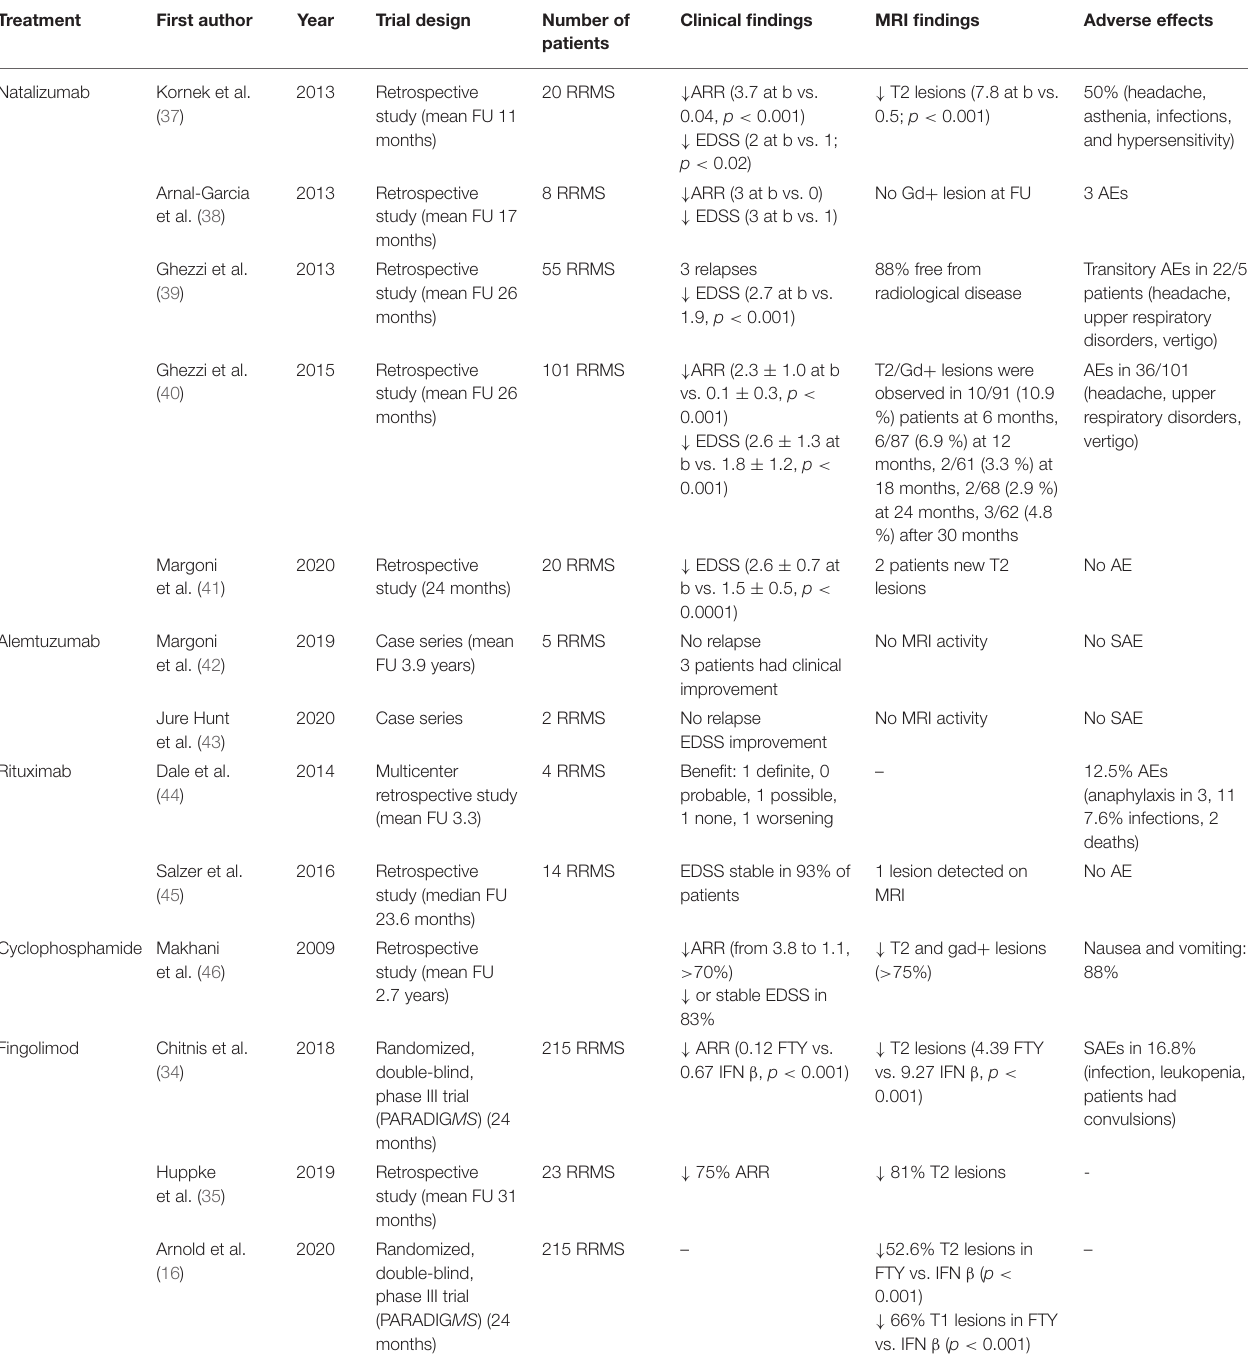
TABLE 2 | Observational and clinical studies on second-line immunomodulatory therapies in pediatric multiple sclerosis.